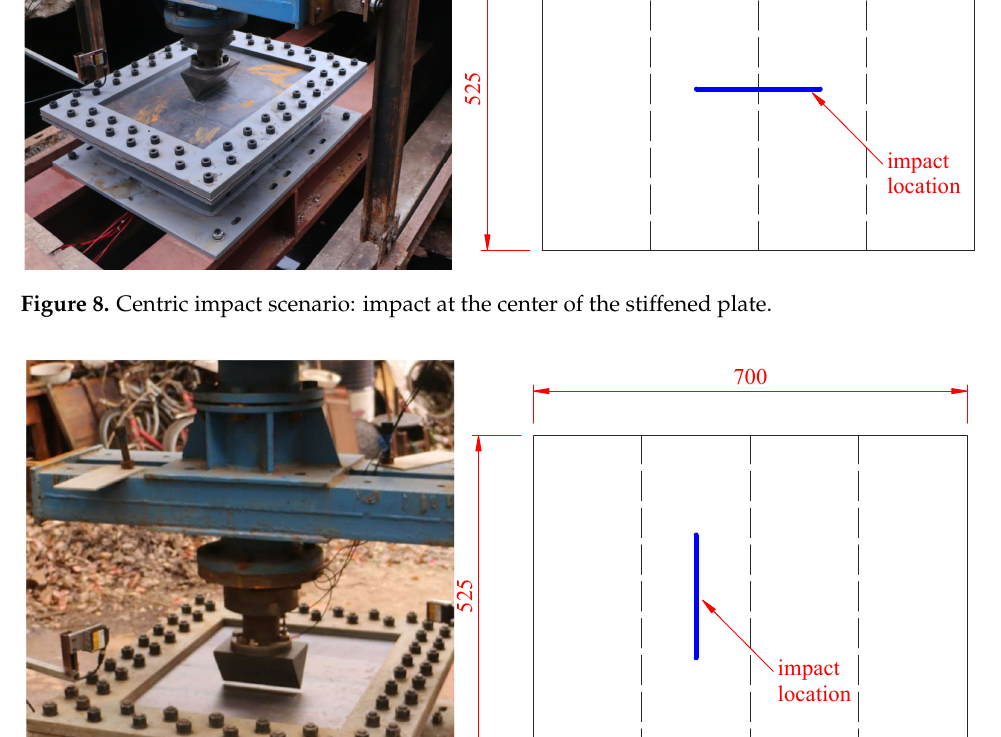
Figure 11. Deformation of the strengthened stiffened plate under centric impact: ( a ) front side; ( b ) back side. Figure 12. Fracture occurred at the cross joint of the stiffeners on the strengthened plate under cen- tric impact. In the eccentric impact scenario, the strengthening stiffener may significantly strengthen the load-carrying capability of the stiffened plate. Deformation and failure modes are shown for both stiffened plates in Figure 13; deformation and failure mainly occurred in the local area between the two stiffeners. As shown in Figure 13a, the plate